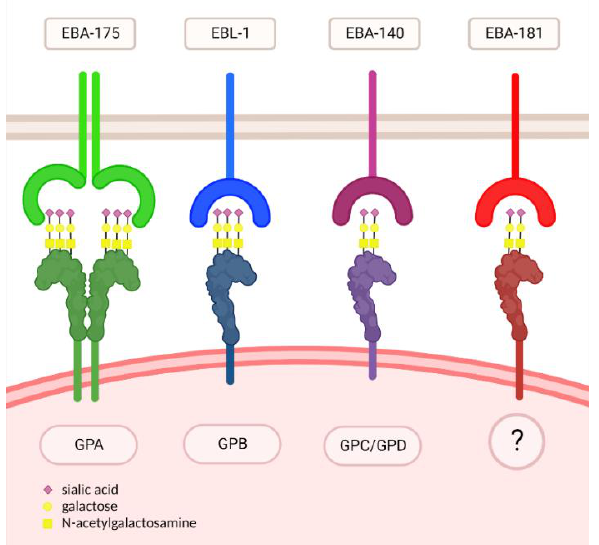
Figure 2. P. falciparum EBL merozoite ligands and glycophorin receptors on